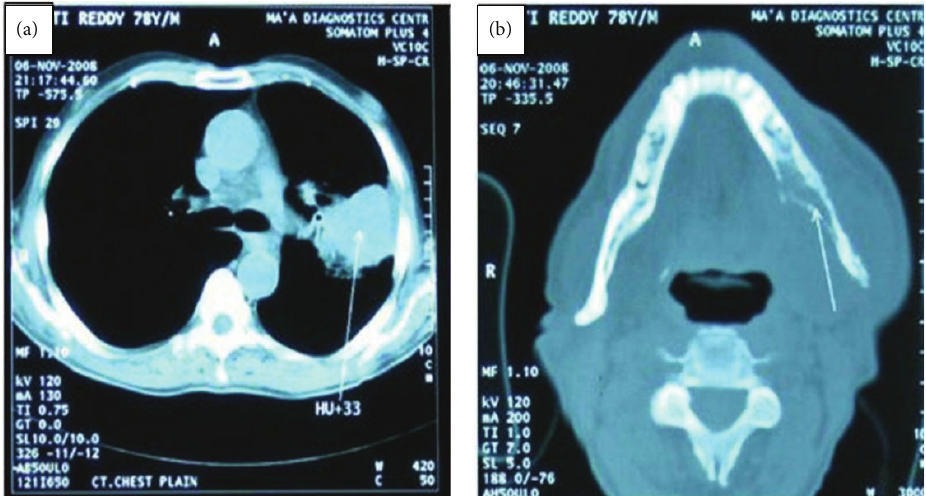
Figure 4: (a) CT chest revealed lesion in the left lung. (b) Axial sectional study of CT mandible revealed osteolysis of left body and ramus of the mandible with adjacent soft tissue mass.